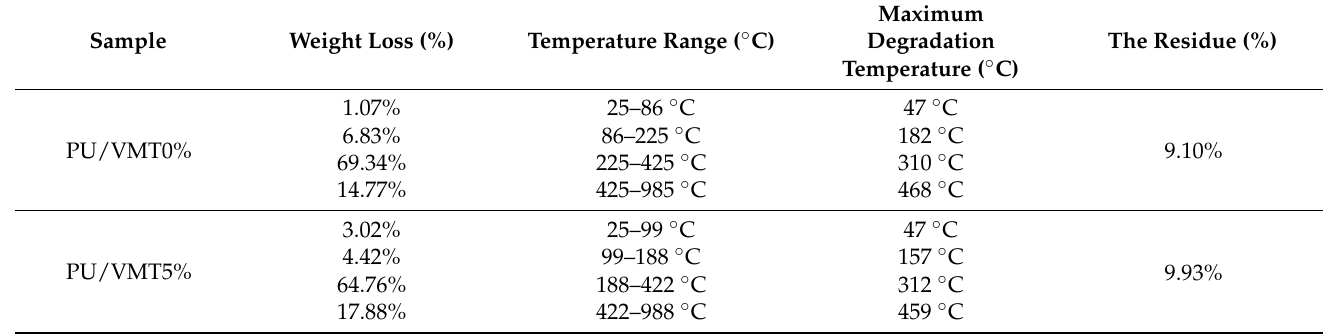
Table 2. Weight loss, temperature range, maximum degradation temperature, and residue of